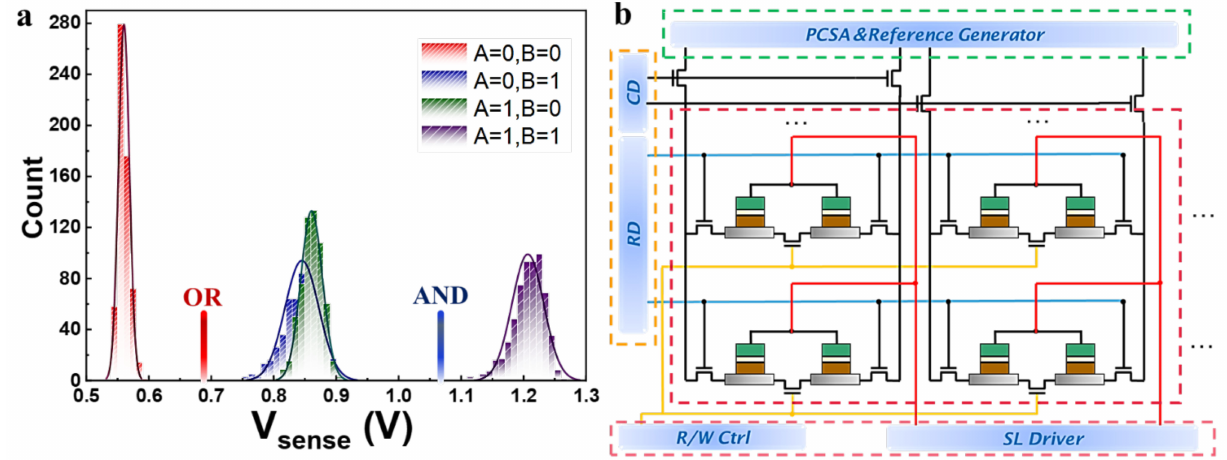
Figure 7. The implication of in-memory logic computation ( a ). Monte Carlo simulation distribution result of the sensing voltage for storing different data in the memory cell ( b